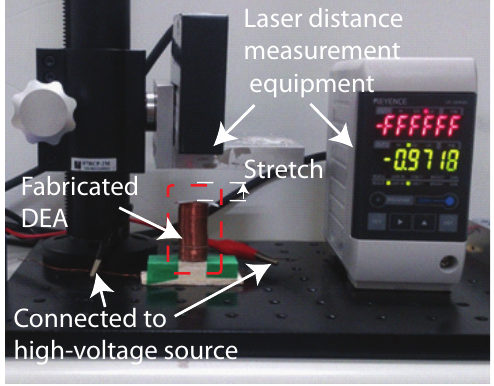
Figure 8. Experiment setup used to characterize electromechanical properties of dielectric DEA: device placed vertically and connected to variable voltage source of 9.9 kV; under application of external voltage, device extended vertically and axial deformations measured using laser-based distance measurement